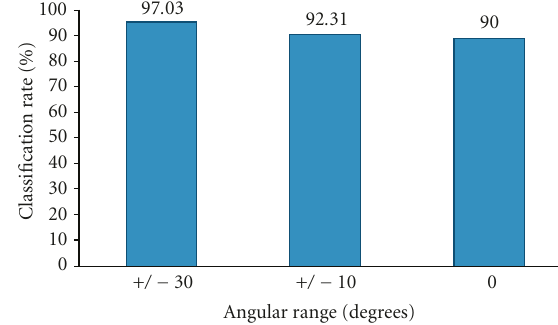
Figure 10: Mean classification rate versus angular